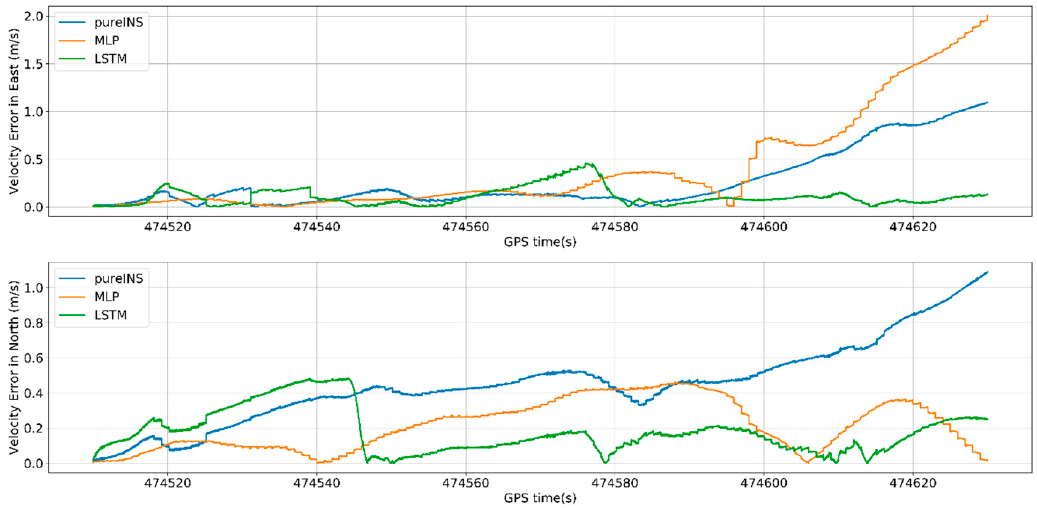
Figure 17. Velocity errors of 120 s outages with different algorithms.